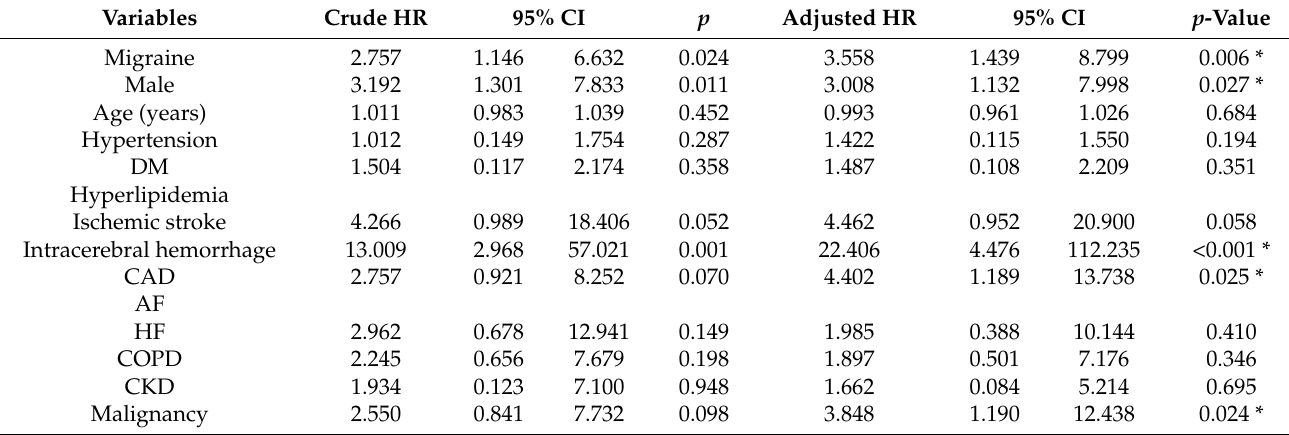
Table 3. Factors associated with abdominal aortic aneurysms according to the Cox regression model.